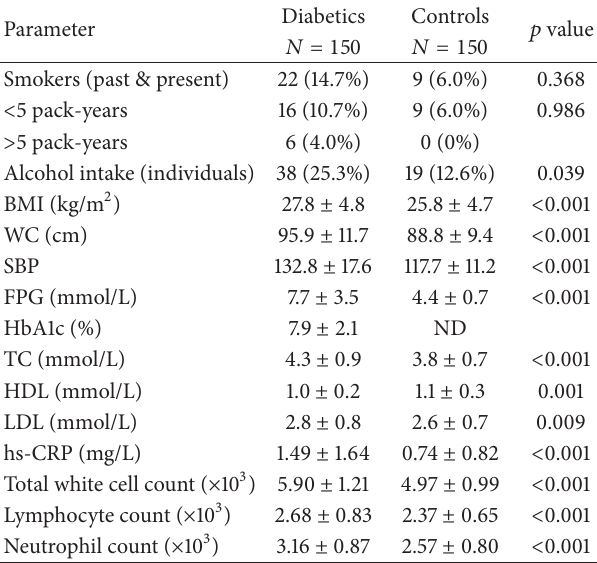
Table 1: Comparison of traditional and nontraditional factors among diabetics and